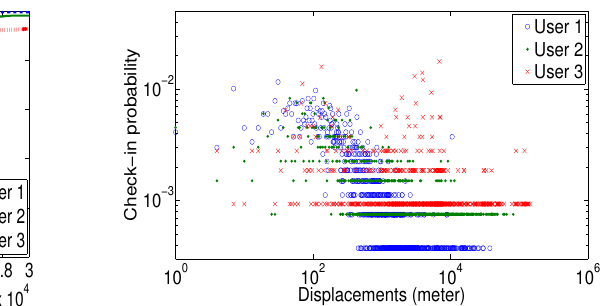
( b ) Check-in probability as a function of displacements. Figure best viewed in color. Figure 1. Heterogeneous mobility